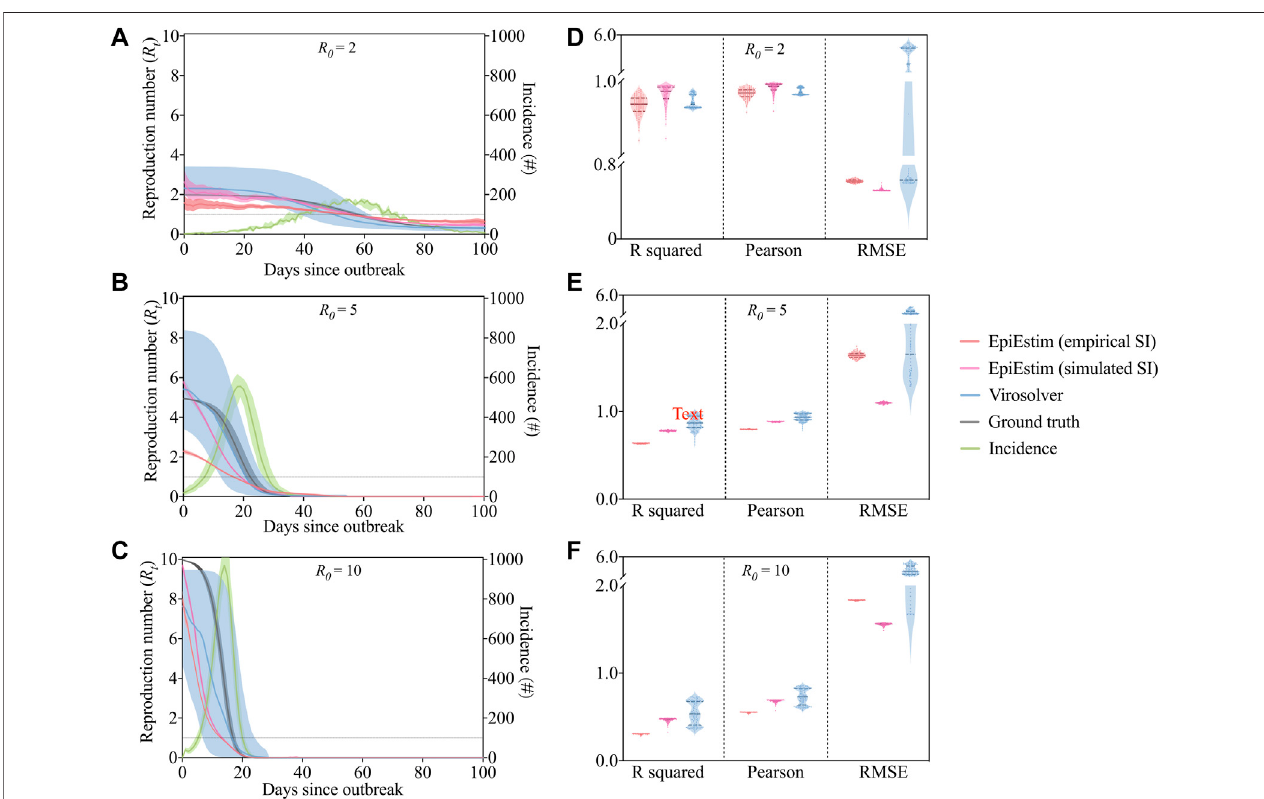
FIGURE 3 | The output of R t estimates in three designed scenarios and the corresponding outcomes of accuracy assessment. (A – C) The graphical interface by setting R 0 (cid:1) 2 , 5 , 10, respectively. We parameterized the serial interval distribution used by EpiEstim with the empirical study [18] and the simulated serial interval distribution, which are denoted by EpiEstim (empirical SI) and EpiEstim (simulated SI) in fi gure legends. (D – F) Results of R squared, Pearson correlation coef fi cient, and RMSE for both methods in scenarios with R 0 (cid:1) 2 , 5 , 10, respectively.